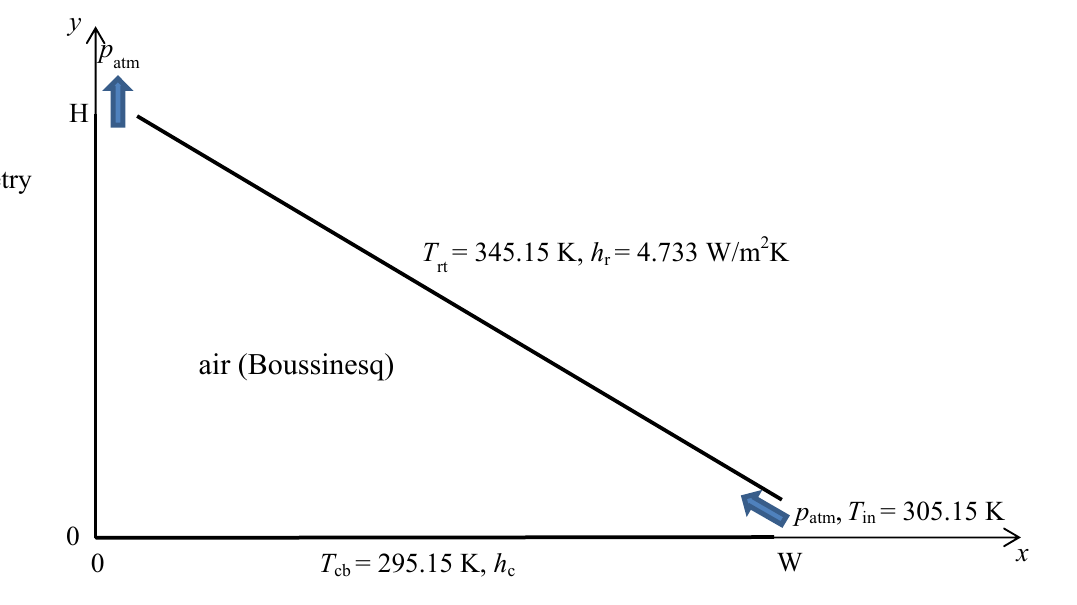
Figure 1. Schematic of the computational domain and boundary